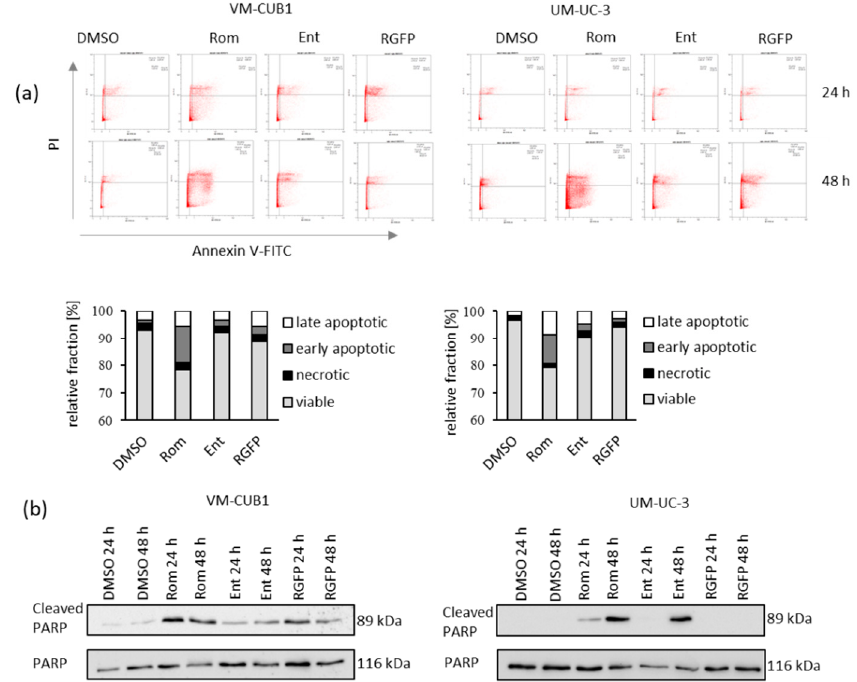
Figure 3. Induction of cell death in UCC after treatment with class I-specific HDACi. ( a ) Induction of cell death was measured by Annexin V/PI staining and flow cytometry 24 and 48 h after treatment with indicated HDACi Romidepsin (Rom), Entinostat (Ent) or RGFP966 (RGFP) compared to DMSO control cells. Cells in the lower left quadrant are viable, in the lower right early apoptotic, in the upper right late apoptotic and in the upper left necrotic. Example raw data of one representative experiment is visualized. Plots for 48 h treatment are additionally displayed enlarged in Figure S2. The means for percentages of cells in the respective quadrants after 48 h from three independent experiments are summarized in bar graphs. ( b ) PARP cleavage was determined by western blot analysis after treatment for 24 and 48 h with indicated HDACi. Total PARP protein was detected as a loading control.